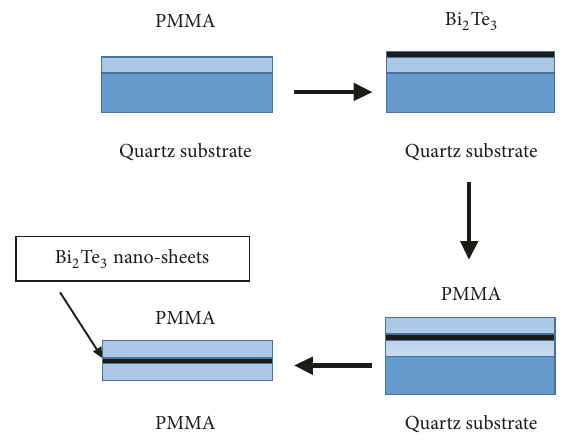
Figure 2: Fabrication of PMMA sandwiched Bi 2 Te 3 nanosheets saturable absorber.